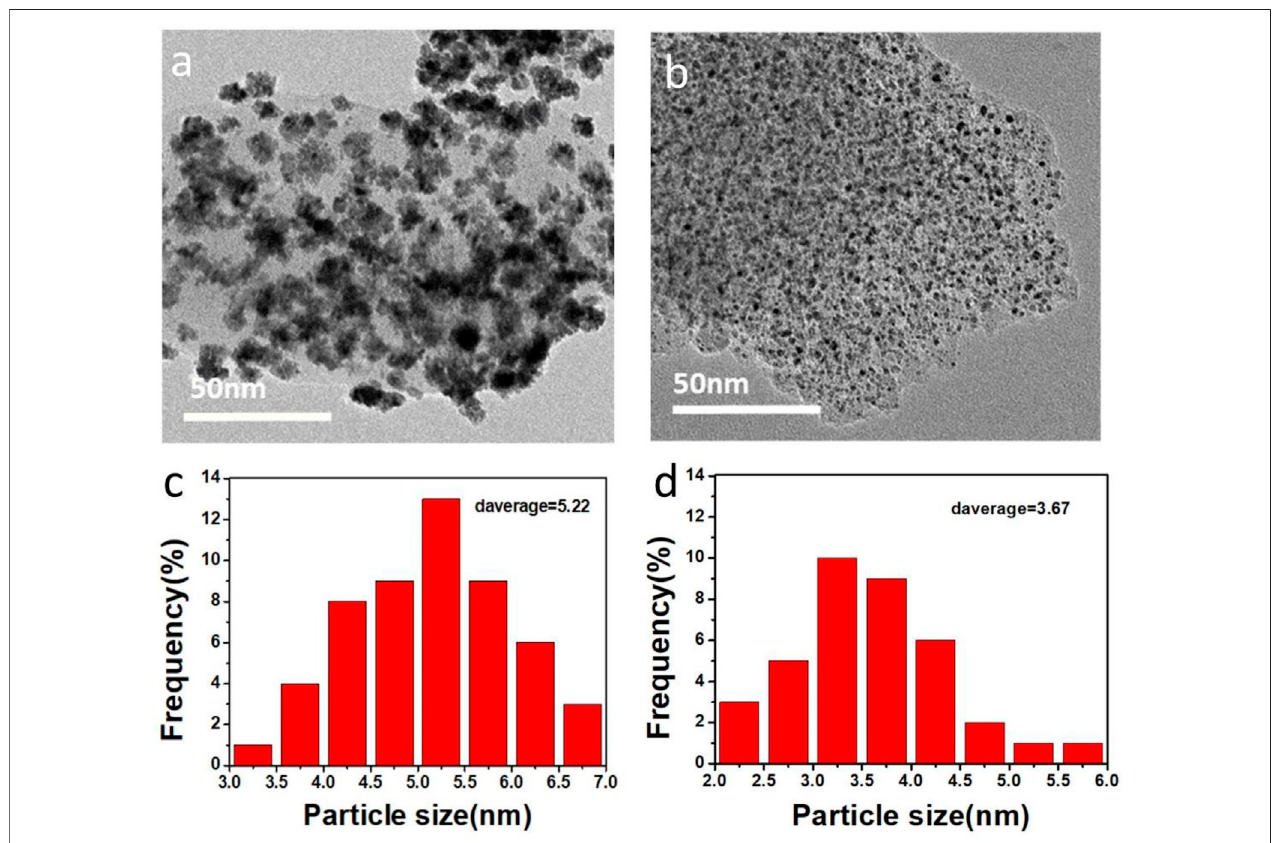
FIGURE4| TEMimagesof (A) PtRu/C-0and (B) PtRu/C-0.75samples,correspondingsizedistributionhistogramsof (C) PtRu/C-0and (D) PtRu/C-0.75samples.